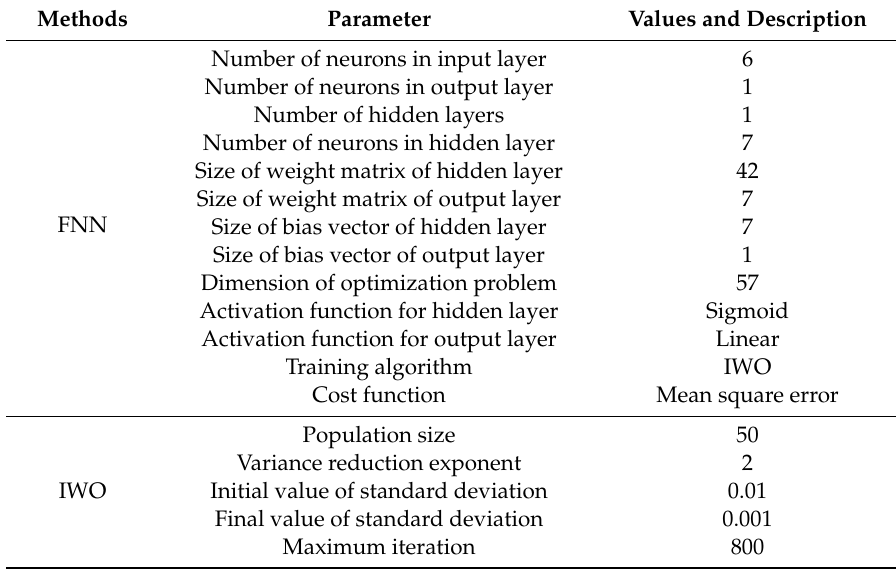
Table 3. Values and description of feedforward neural network (FNN) and invasive weed optimization (IWO) parameters in this